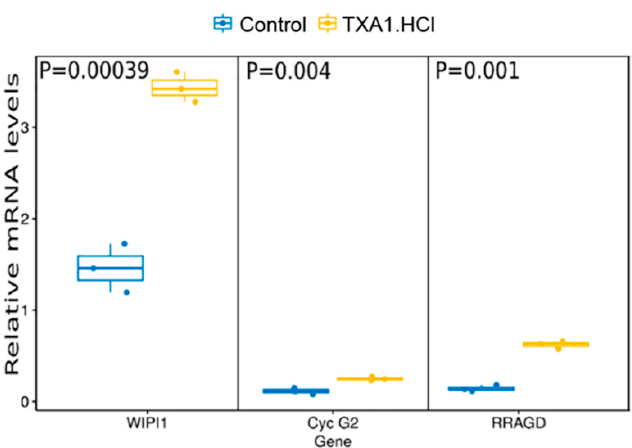
Figure 7. TXA1.HCl treatment affects WIPI1, Cyclin G2 and RRAGD mRNA expression levels, confirmed by quantitative real-time PCR. Values are expressed after normalization for an endogenous control (Hprt1). Data plotted with ggplot and p values were calculated using t test in R statistical programming language, comparing TXA1.Hcl treatment vs. control.